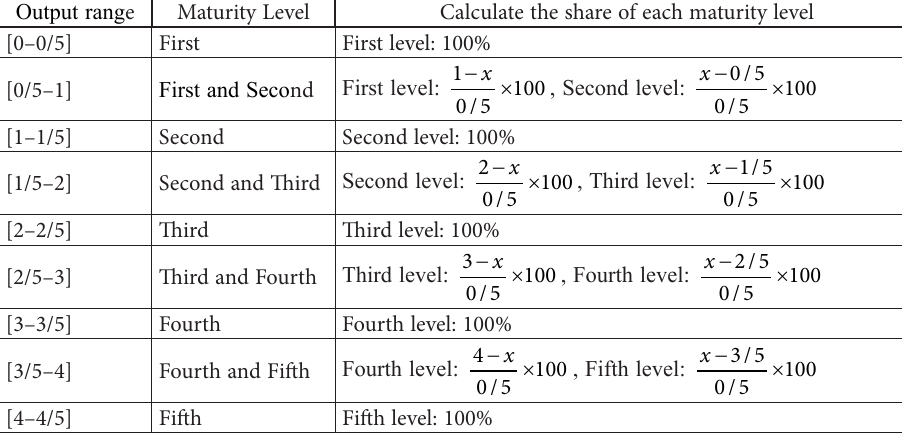
Table 7. Calculate the share of each maturity level based on membership functions Output rang e Maturity